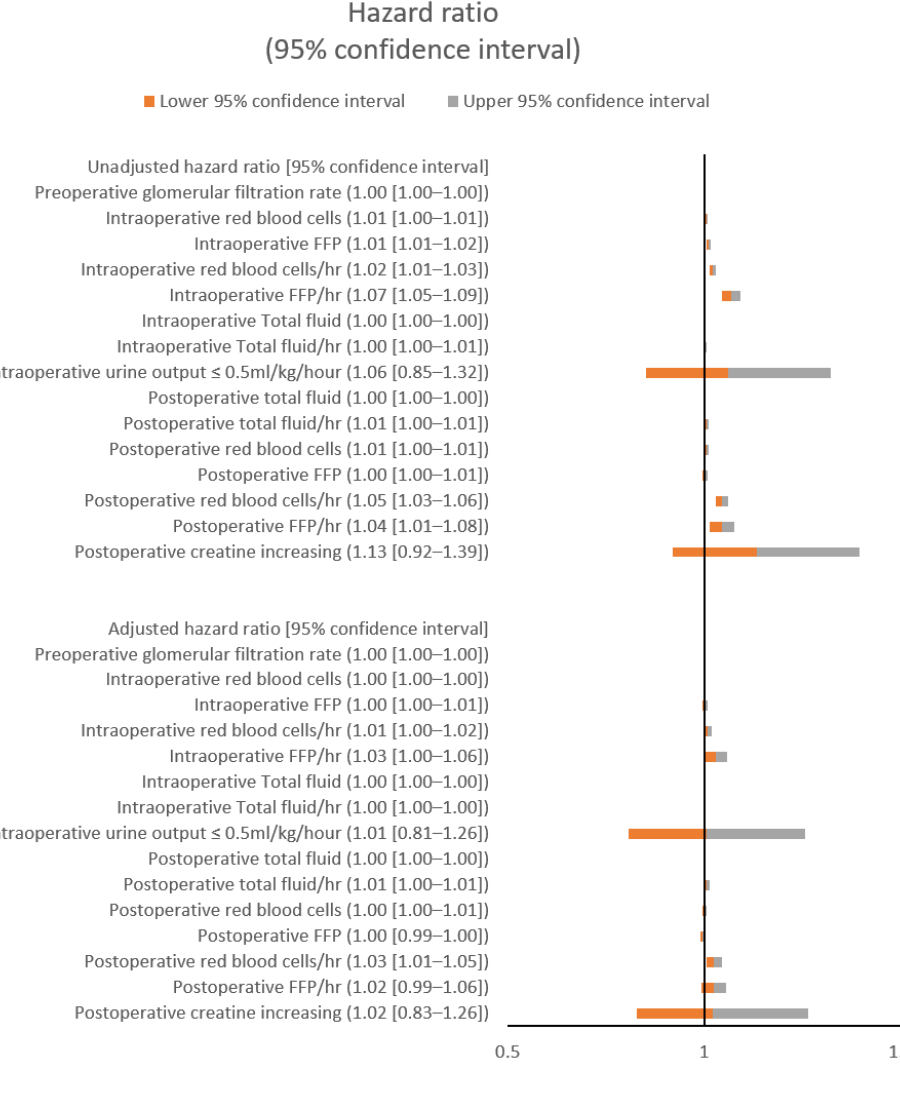
Figure 1. Unadjusted and adjusted hazard ratios for postoperative pulmonary edema. FFP: fresh frozen plasma.